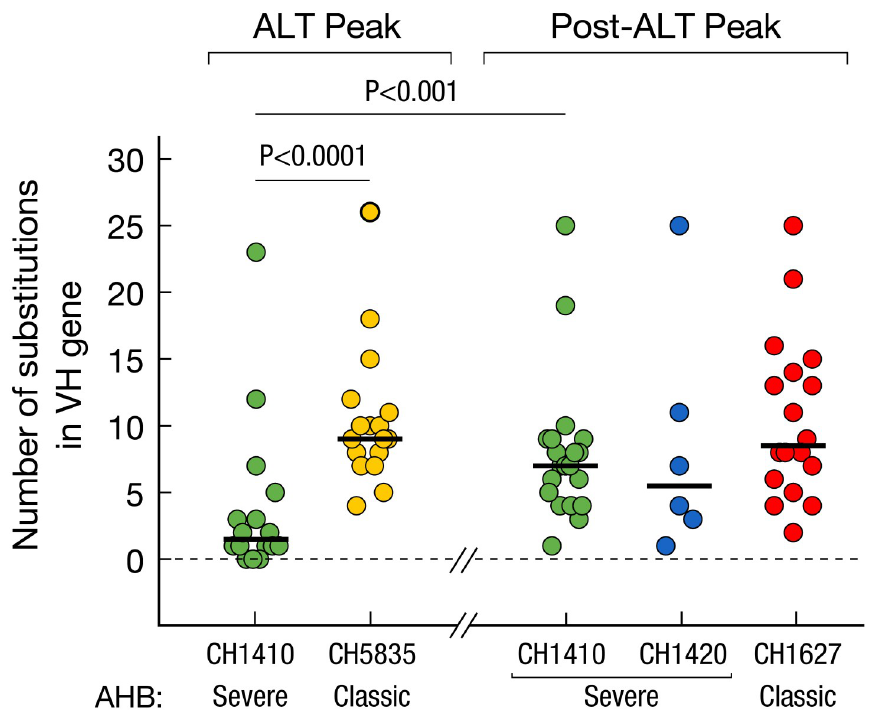
Fig 5. Average frequency of somatic hypermutation in VH genes coding for anti-HBc antibodies among IgG sequences obtained from the liver of chimpanzees with severe and classic AHB. Solid lines show the medians. P values refer to comparisons performed using the two-tailed Mann-Whitney test.